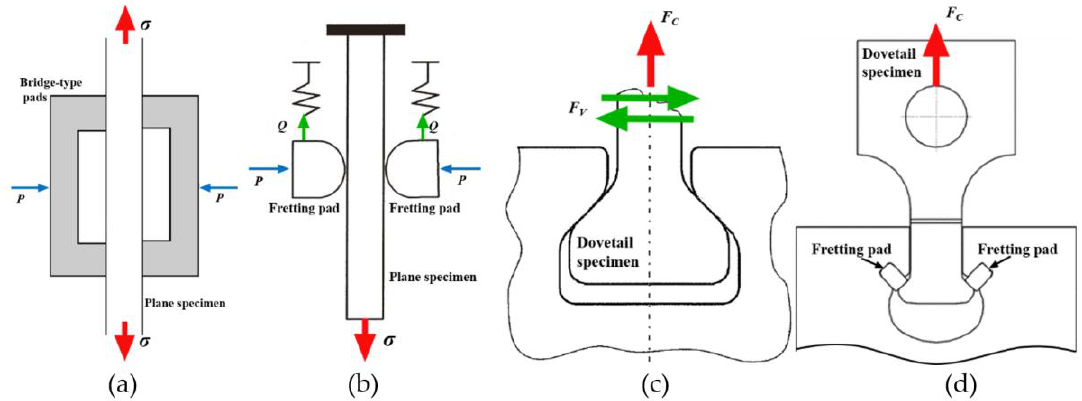
Figure 1. Illustration of different fretting fatigue arrangements. ( a ) Bridge-type; ( b ) block-type; ( c ) dovetail-type; ( d ) dovetail-type with pads.